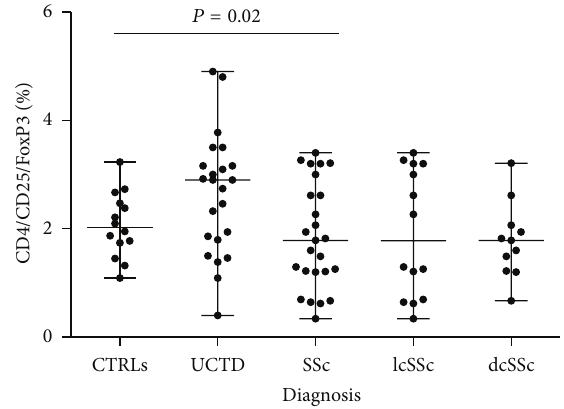
Figure 2: Levels of T reg cells (CD4+/CD25+/FoxP3+) in controls and patients with UCTD or cSSc are significantly